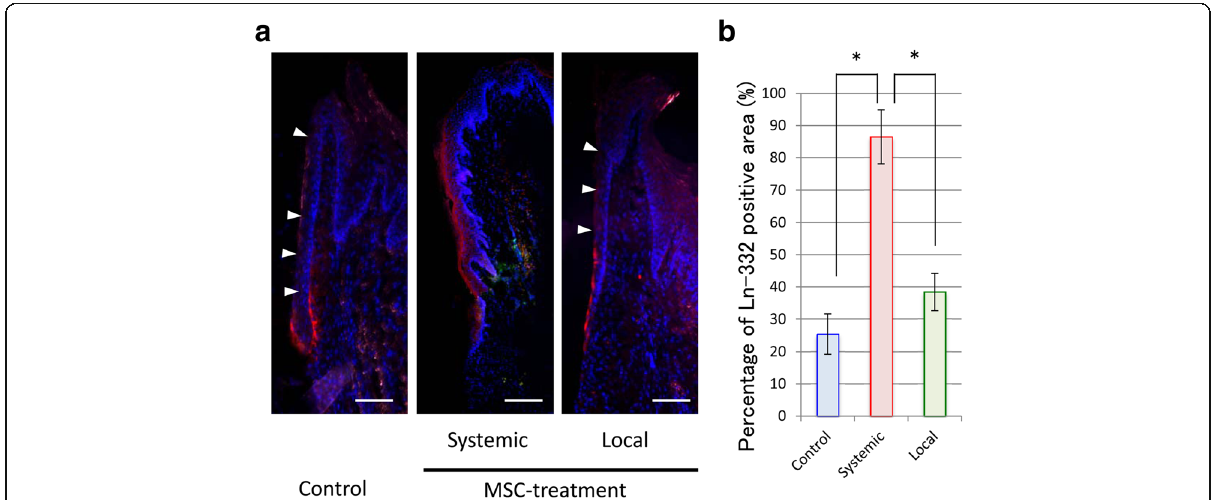
Fig. 3 Ln-332 distribution on peri-implant epithelium (PIE) after MSC injection. a Light micrographs of Ln-332 distribution (red staining) in the gingiva around the control, local, and systemic group implants after 4 weeks. White arrowheads indicated lack of positive reaction. Blue staining: DAPI (bar = 200 μ m) ( b ). Quantitation of Ln-332 presence in the PIE. Images were analyzed to quantify Ln-332 expression in the PIE around the implants. Each data point represents the mean ± SD of the three independent experiments. * p <